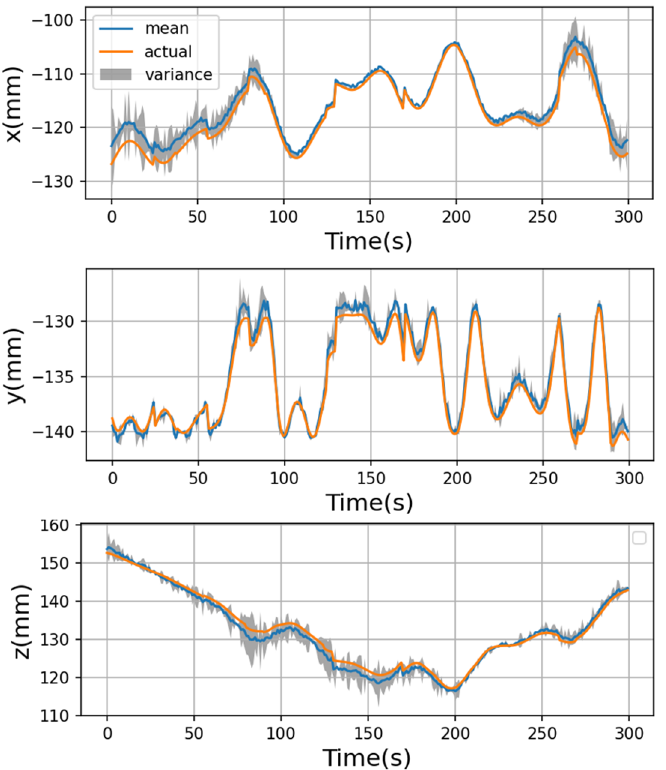
Figure 7. Estimations of µ and σ 2 were made by the LSTM network vs. the ground truth value provided by the vision positioning module.